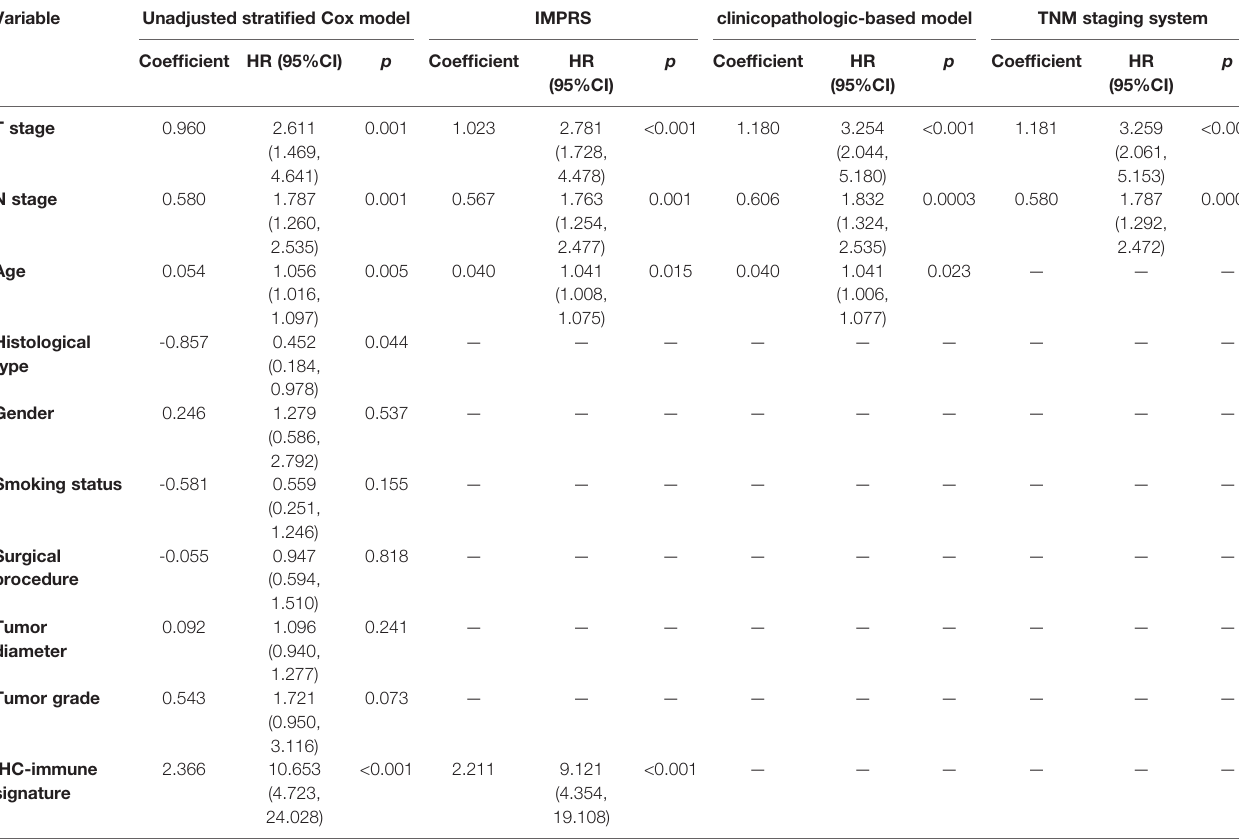
TABLE 3 | Multivariate Cox proportional hazard analysis for prediction of OS among patients with resected NSCLC. Variable